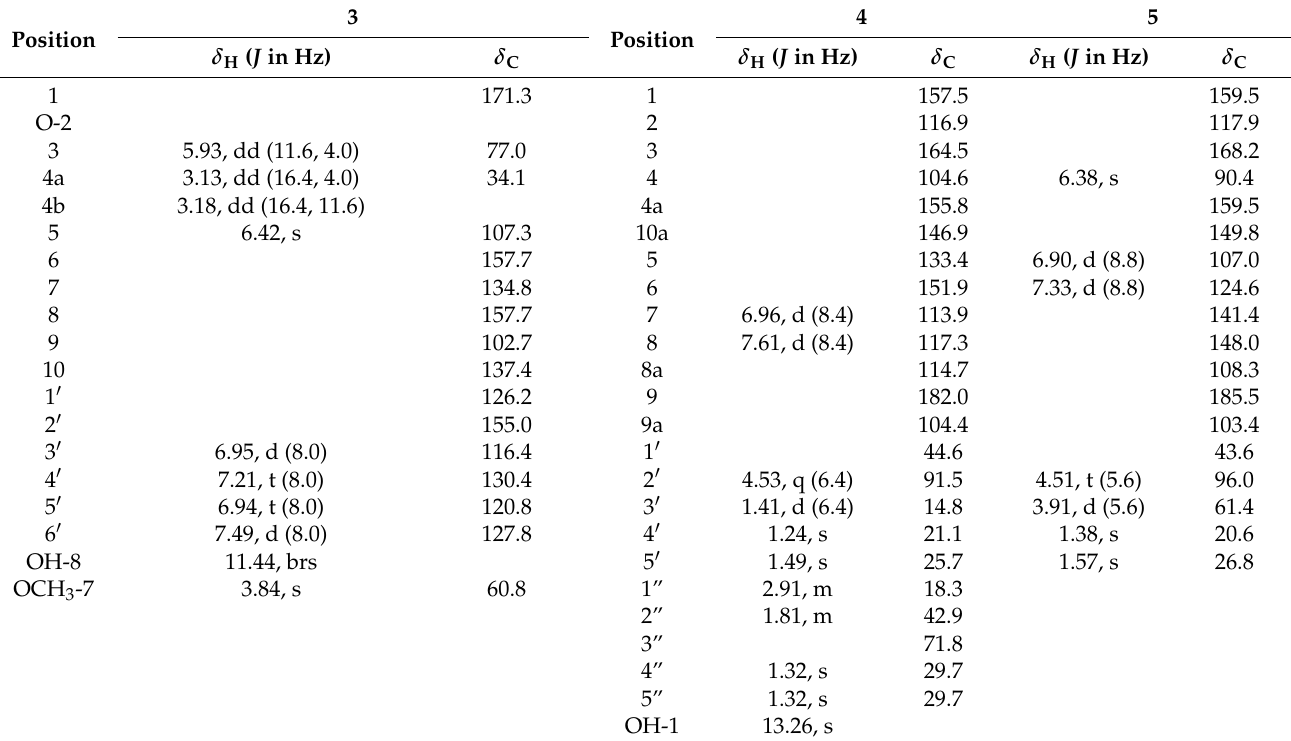
Table 1. 1 H- (400 MHz) and 13 C- (100 MHz) NMR spectroscopic data of compounds 3 - 5 recorded in acetone- d 6 ( δ in